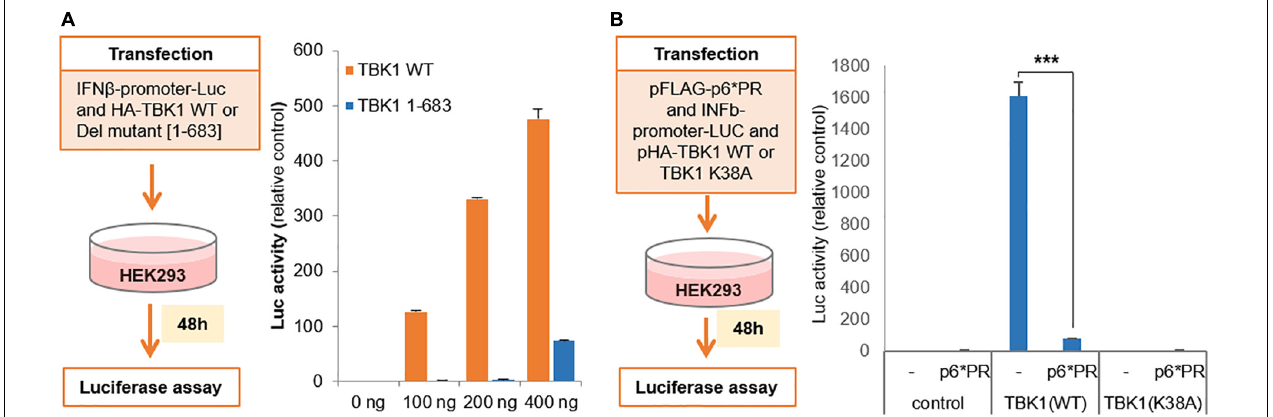
FIGURE 3 | Cleaved TBK-1 does not activate IFN β promoter. (A) Interferon β -promoter-Luc genetic element was co-transfected with serial concentrations of HA tagged wild type TBK1 or its deletion mutant [1–683] in HE293 cells. Relative luciferase activity denoting the interferon β promoter activity was assessed after 48 h of transfection. Bars represent the mean value of three replicates tested. (B) pFLAG-p6*PR, interferon β -promoter-Luc and either pHA-TBK1 wild type or non-functional mutant TBK1 K38A were co-transfected in HEK293 cells. Relative luciferase activity denoting the interferon β promoter activity was assessed after 48 h of transfection. Bars represent the mean value of three replicates tested. *** indicates p -value < 0.001.